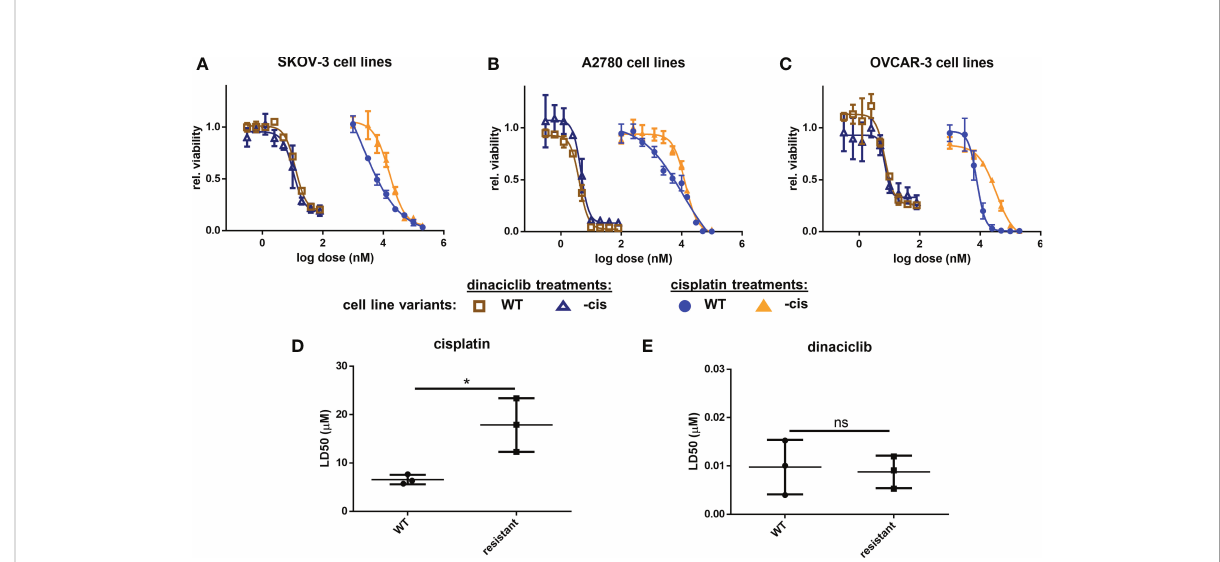
FIGURE 2 Dinaciclib is effective in cisplatin resistant cell lines. Dose-response experiments for cisplatin and dinaciclib are performed on cisplatin sensitive and resistant cell line variants for (A) SKOV-3 and SKOV-3cis (B) A2780 and A2780cis and (C) OVCAR-3 and OVCAR-3cis cells. Viability is normalised to media controls. LD50s for all cell lines are shown in (D) for cisplatin, and (E) for dinaciclib. Data are expressed as mean of three independent experiments with error bars representing standard deviation. Statistical signi fi cance was calculated by ANOVA followed by Dunnett ’ s test. *p value < 0.05, ns, not signi fi